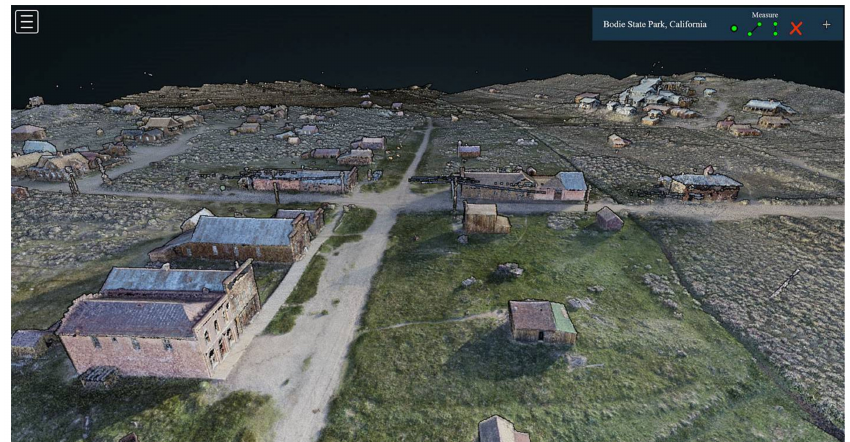
Figure 12. View of the Bodie downtown point cloud in our instance of the Potree viewer, as it was captured in 2020 using drone-based IBM. The Dechambeau Hotel and IOOF Hall are seen along Main St. ( bottom left ). The Standard Stampmill complex is seen on the slope adjacent to the town ( top right ). Visualization by S. McAvoy.